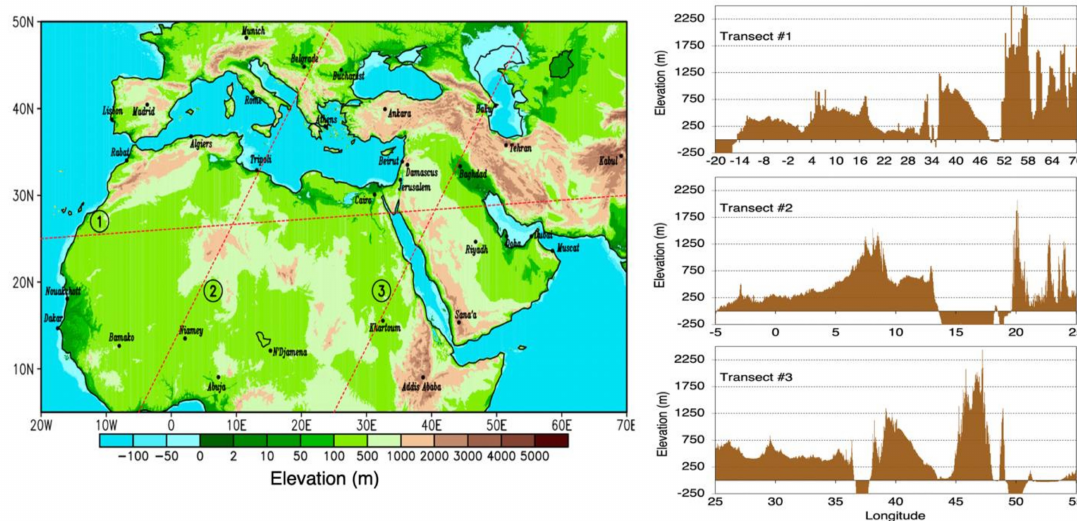
Figure 1. Topographical map of the Middle East and North Africa (MENA) using the NOAA National Geophysical Data Center’s ETOPO1 Global Relief Model. The map shows the elevation (m) for the MENA domain. The three transects that intersect the region are shown with red dashed lines and are highlighted in the subpanels on the right. The high elevation in certain areas are highlighted here, such as the mountain terrains in Turkey and